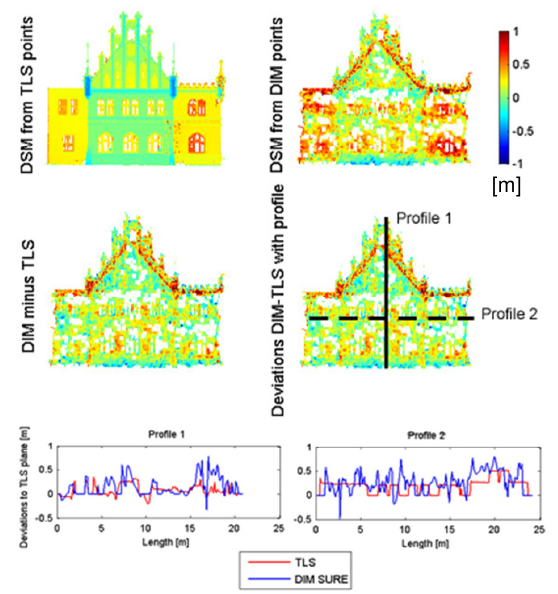
Figure 6. Example evaluation of DIM in PentaCam images.